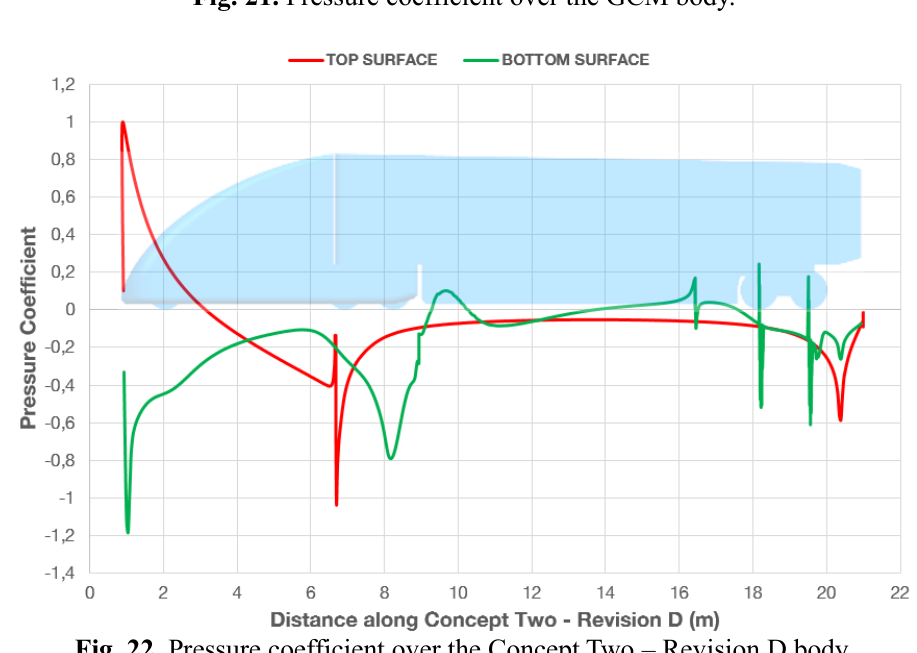
Fig. 21. Pressure coefficient over the GCM body.